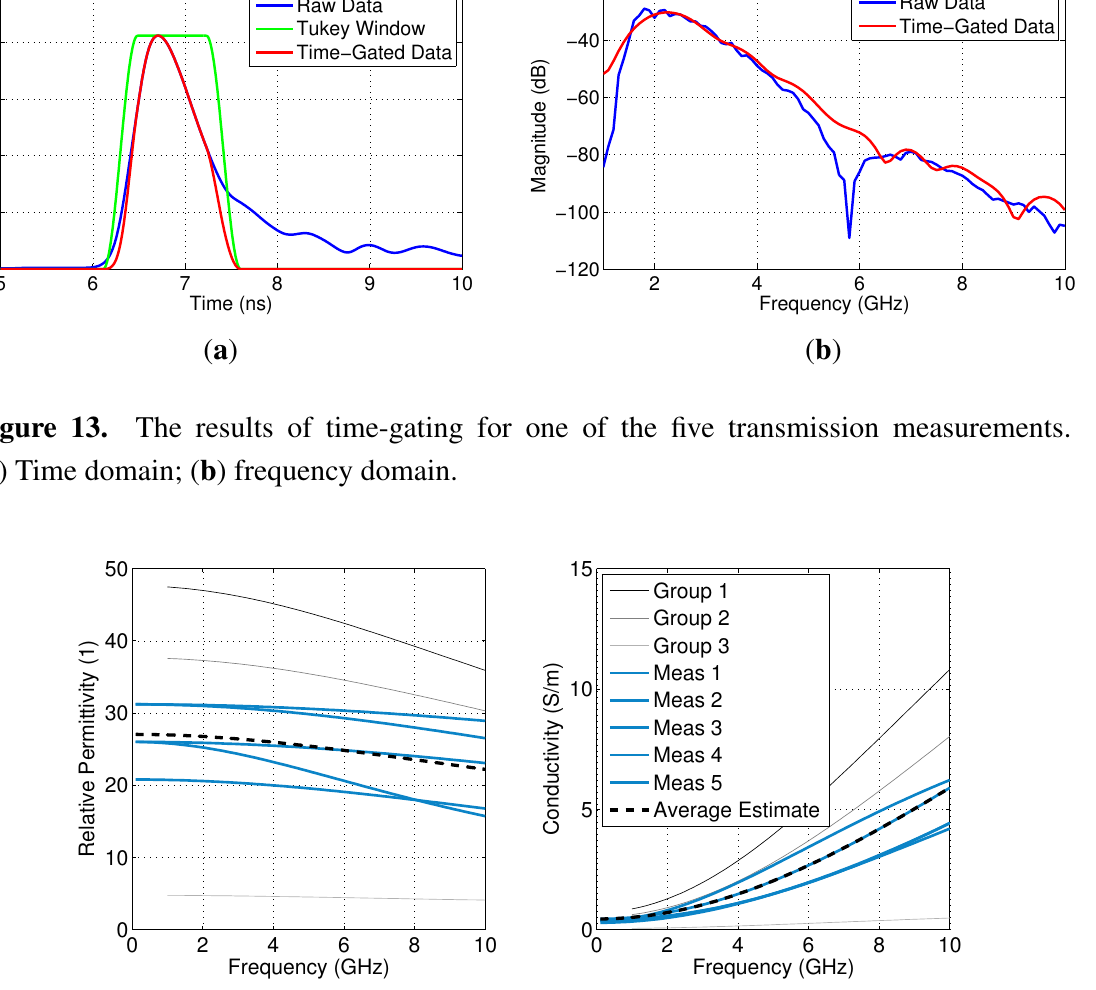
Figure 14. Estimated average DPs for results taken from a recent patient. The DPs of different breast tissue groups is included for comparison